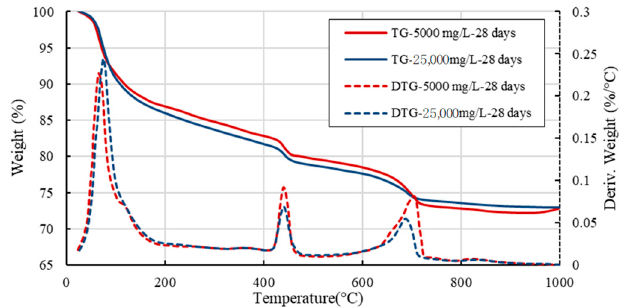
Figure 14. TG/DTG charts for specimens treated for 28 days with initial sulfate concentrations of 5000 mg/L and 25,000